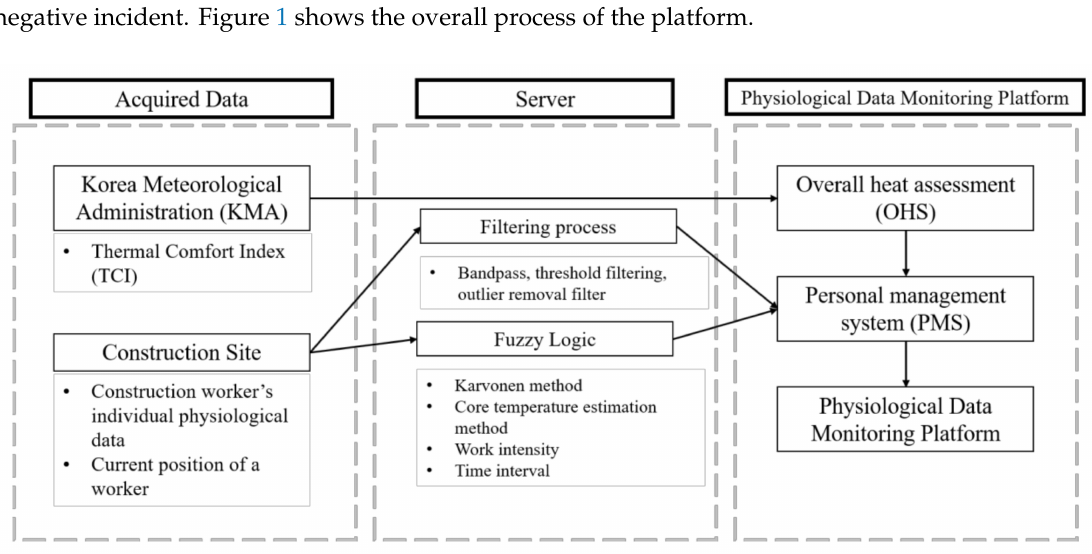
Figure 1. Overview of the physiological data monitoring